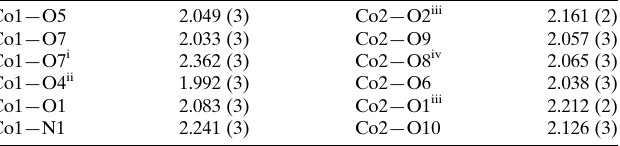
Table 1 Selected bond lengths (A˚ ).